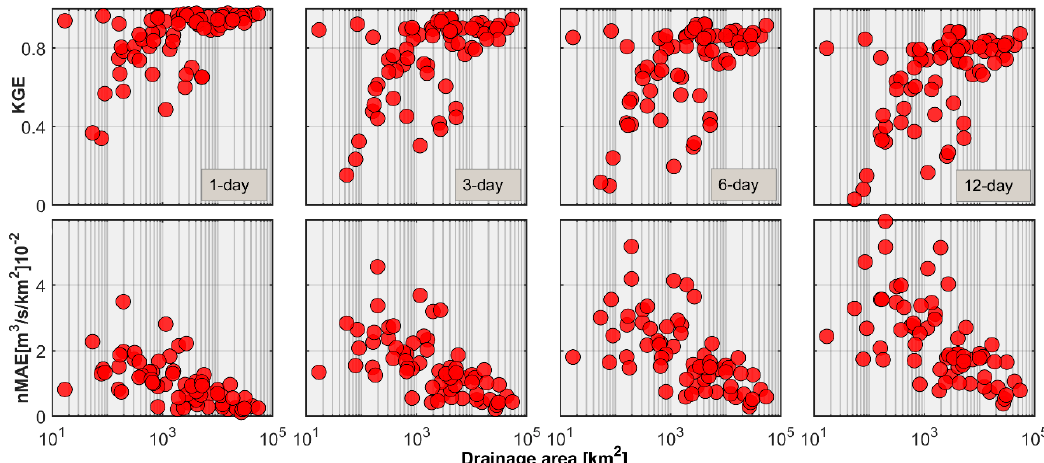
Figure 3. Relationship of skill metrics with drainage area for the entire Nepal. The columns show 1, 3, 6 and 12 day lead times, while the rows show Kling–Gupta efficiency (KGE ) and normalized mean absolute error ( nMAE ), respectively.